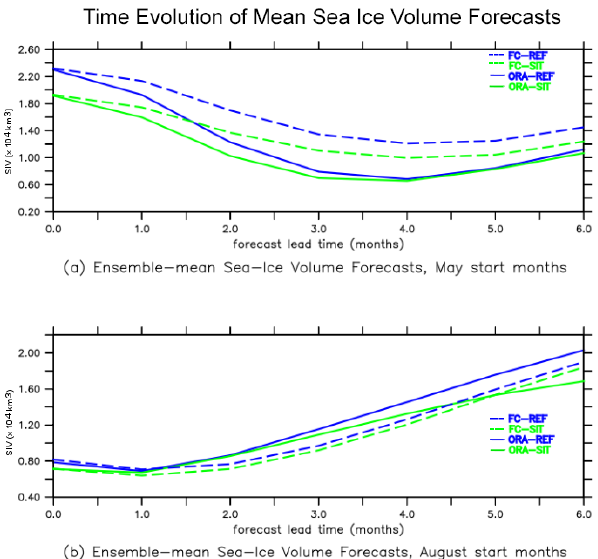
Figure 8. Time series of ensemble mean sea ice volume (units are 10 4 km 3 ) forecasts averaged over 2011–2015 for the May start date (a) and August start date (b) in reference reforecast (FC-REF, dashed blue line) and reforecast with thickness initialization (FC- SIT, dashed green line) compared to their own reanalyses, ORA- REF (solid blue line), and ORA-SIT (solid green